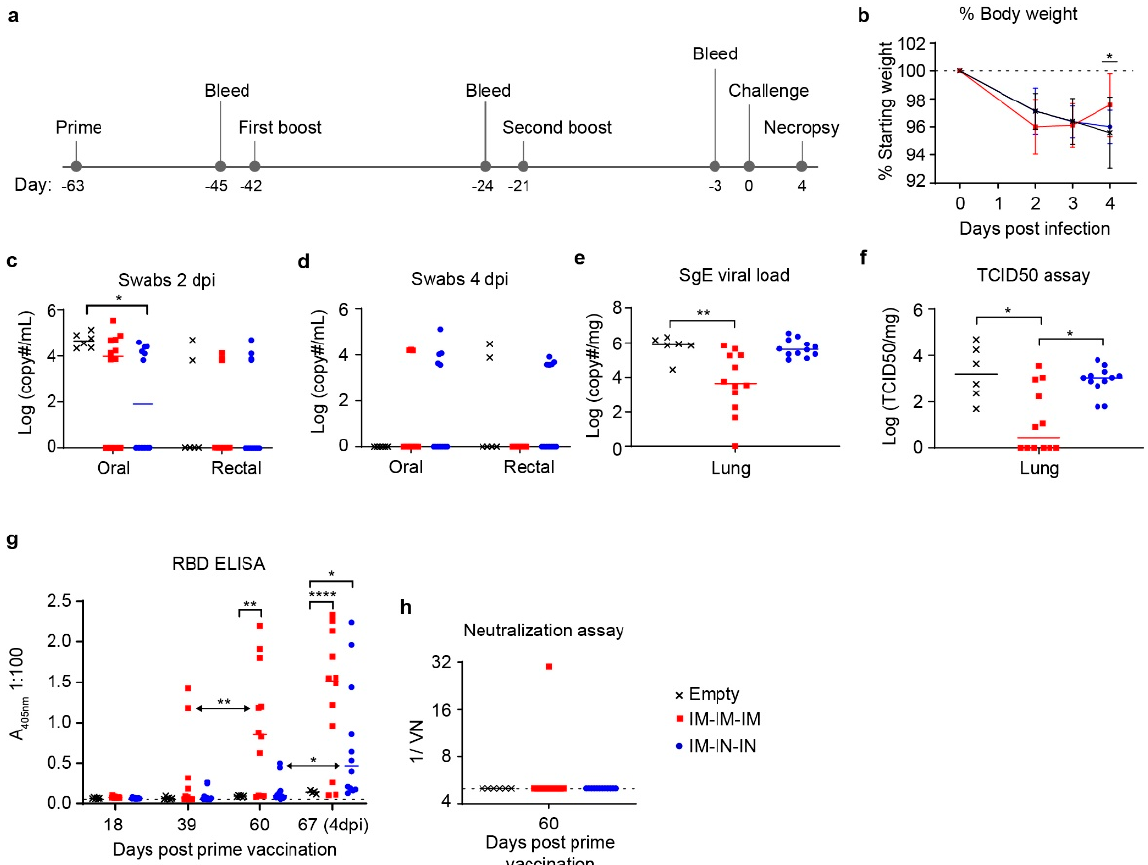
Figure 3. Prime-Boost-Boost Hamster Body Weight, Viral Loads, and Antibody Characterization. Prime-Boost-Boost hamsters were divided into two spike-vaccinated groups receiving IM-IM-IM or IM-IN-IN vaccinations of 50 µ g Sp_pVax1 DNA plasmid complexed to in vivo delivery reagent. n = 12 per group ( a ) 3-weeks post prime, hamsters received boost, with second boost 3 weeks post first boost, and 3-weeks later were challenged IN with 1000 TCID 50 of SARS-CoV-2 for four days. Vaccine efficacy was evaluated via comparison of spike-vaccinated and control ( b ) weight over course of infection, detailed weight loss for individual animals can be found in Appendix A Figure A3, ( c ) oral/rectal swabs at 2 dpi, ( d ) oral/rectal swabs at 4 dpi, ( e ) lung viral loads by SgE PCR at 4 dpi, ( f ) lung infectious virus TCID 50 at 4 dpi, ( g ) RBD antibody titers by ELISA at D18 (three weeks post prime), D39 (three weeks post first boost), D60 (three weeks post second boost), and D67 (final day of infection), and ( h ) neutralization assay of sera from D60. Statistical analyses were done using Kruskal Wallis and 2-way ANOVA where * p < 0.05, ** p < 0.01, **** p <